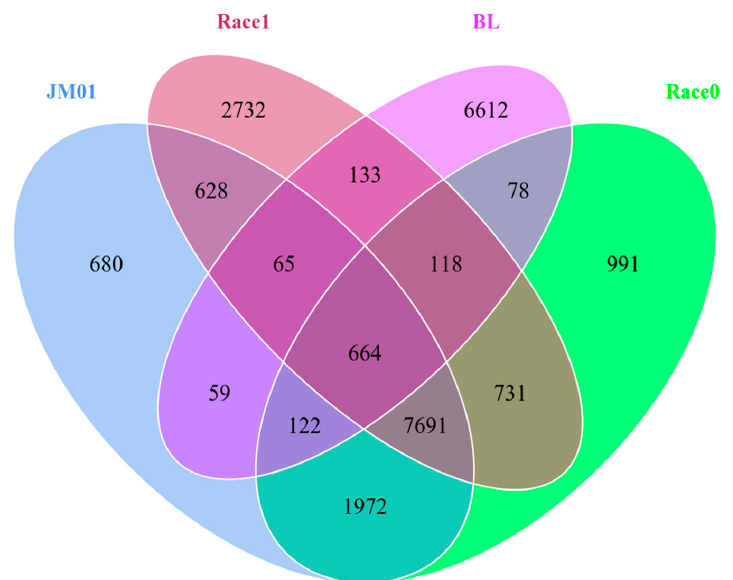
Figure 5. Venn diagram showing the core and pan genes among four Ph. nicotianae genomes. Names of each species were listed beside the diagram component. Ph. nicotianae JM01 (JM01); Ph. nicotianae race 0 (race 0); Ph. nicotianae race 1 (race 1); Ph. nicotianae BL (BL). To investigate the genomic structure in four Ph. nicotianae genomes, MUMmer software (Version 3.23) was used to analyze the genome synteny. The syntenic regions comparison showed that these genomes shared common syntenic regions. However, some structural rearrangement such as inversion and translocation still happened after the divergence of these strains (Figure 6). In detail, the Ph. nicotianae JM01 and Ph. nicotianae race 0, Ph. nicotianae JM01 and Ph. nicotianae race 1, Ph. nicotianae JM01 and Ph. nicotianae BL shared 12,922, 12,179 and 14,429 blocks, respectively. Between Ph. nicotianae JM01 and Ph. nicotianae race 0 (Supplementary Table S4), 6269 locations experienced inversion, and 12,663 locations experienced translocation. Additionally, 3706 inversions and 11,840 translocations were found between Ph. nicotianae JM01 and Ph. nicotianae race 1 (Supplementary Table S5). In addition, we found that 5182 locations experienced inversion, and 6015 locations experienced translocation between Ph. nicotianae JM01 and Ph. nicotianae BL (Supplementary Table S6).